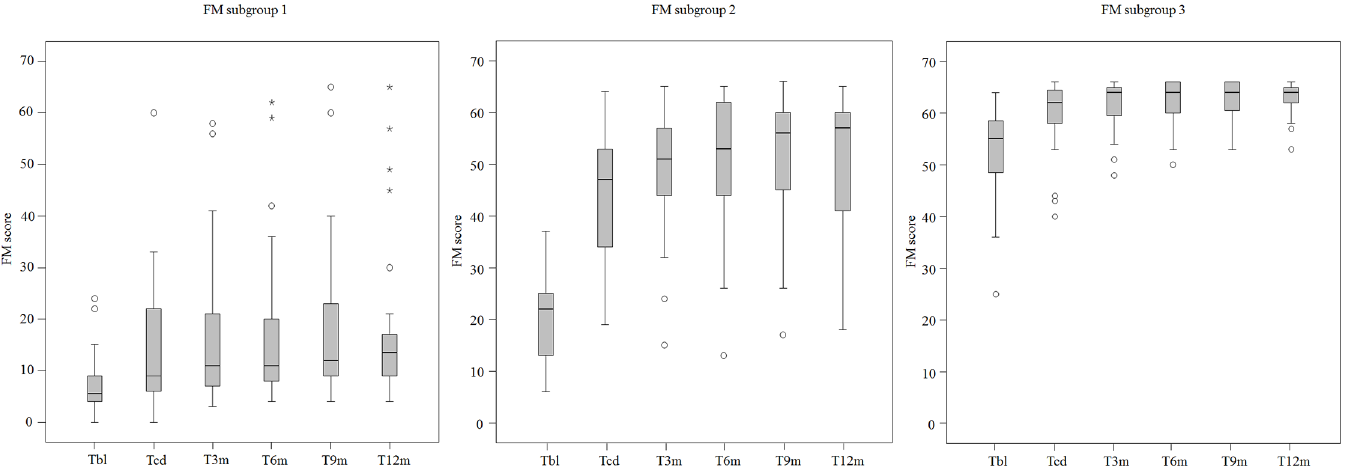
Fig 2. Boxplots of the FM data per measurement moment for each of the three groups. FM = Fugl Meyer Motor Assessment; T BL = Baseline;T CD = clinicaldischarge; T 3m = (= T CD + 3 months); T 6m (= T CD + 6 months); T 9m (= T CD + 9 months);T 12m (= T CD + 12 months). Circle = outlier value; Asterisk = far out value.